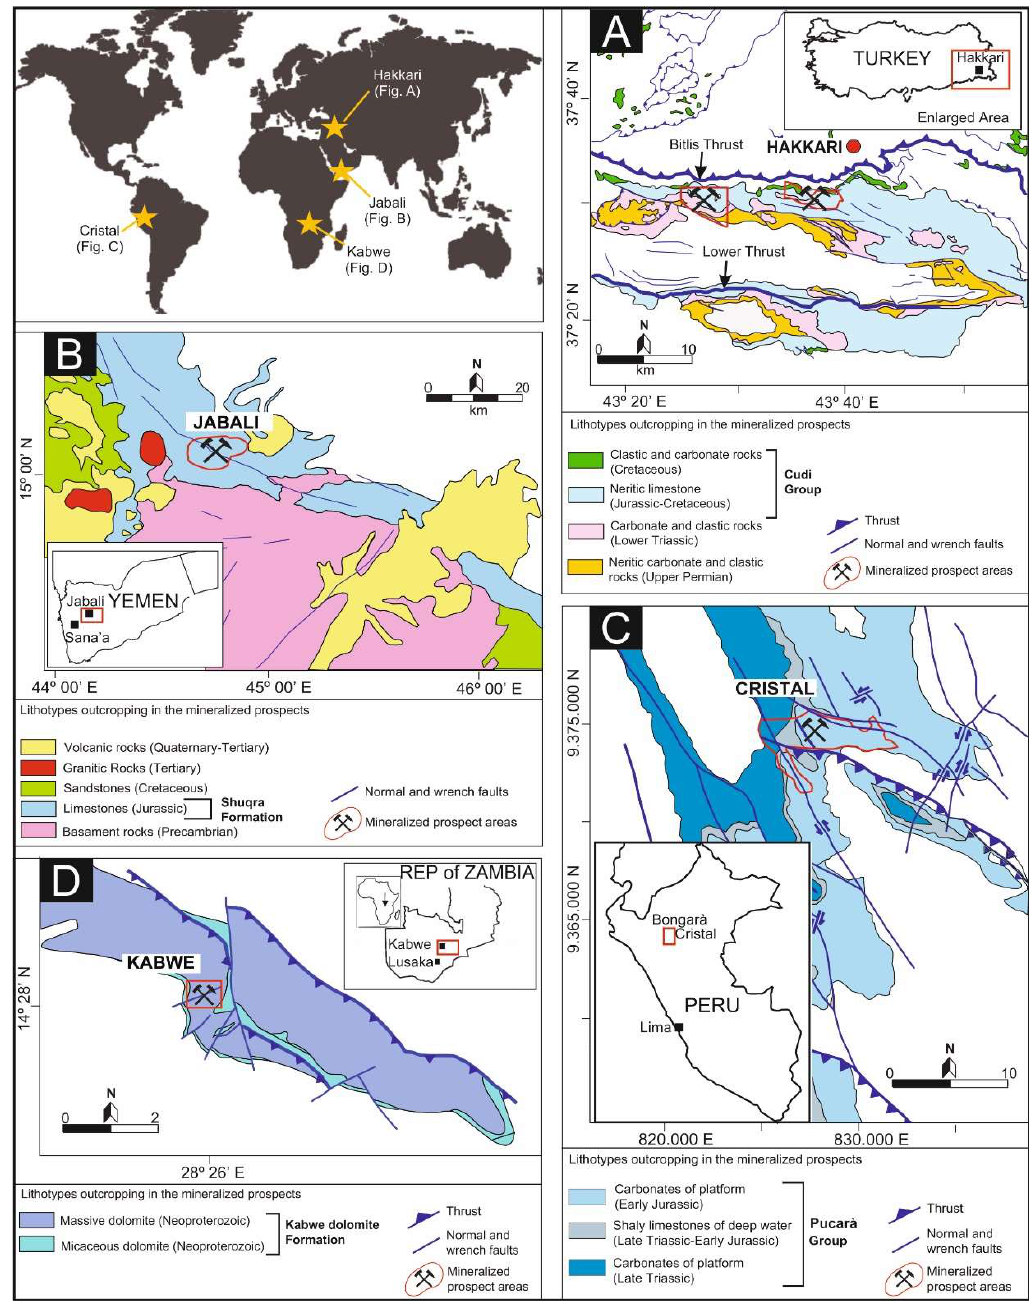
Figure 1. Location and geotectonic framework of the studied deposits: ( A ) Hakkari (Turkey; modified from Reference [29]), ( B ) Jabali (Yemen; modified from Reference [3]), ( C ) Cristal (Peru; modified